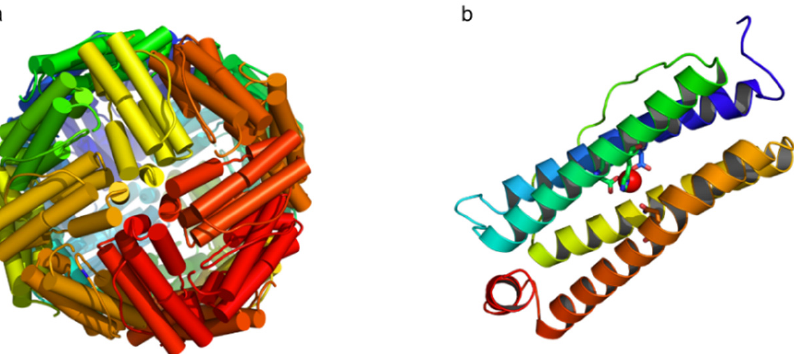
Figure 1. Scheme of the mitochondrial ferritin structure. ( a ) the three-dimensional structure of homopolymer mitochondrial ferritin and ( b ) ribbon representation of four-helix bundle subunit consisting of two couples of anti-parallel α -helices connected by a long loop and a short C-terminal α -helix. The residues involved in iron coordination are evidenced. The structures were obtained using PyMOL from Protein Data Bank (PDBsum